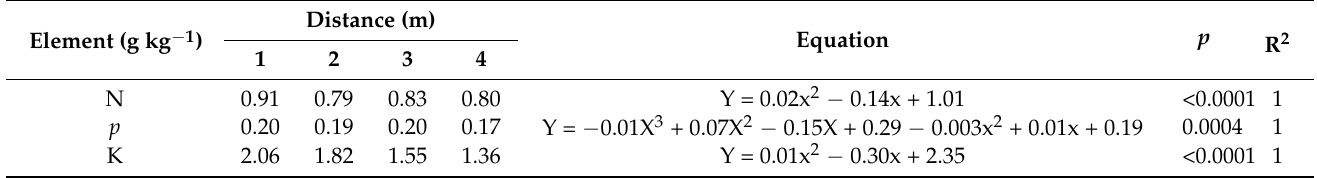
Table 9. Nutrient concentrations (N, p , and K) of forage cactus at different distances from legume trees. Element (g kg − 1 )